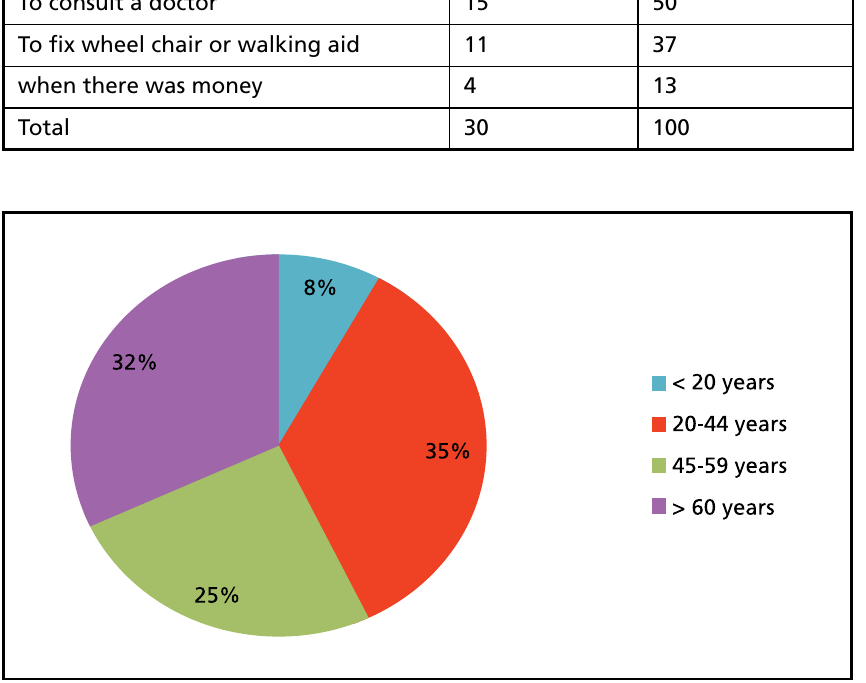
Figure 1: age distribution of patients with a stroke (n=85) attending physio- therapy for